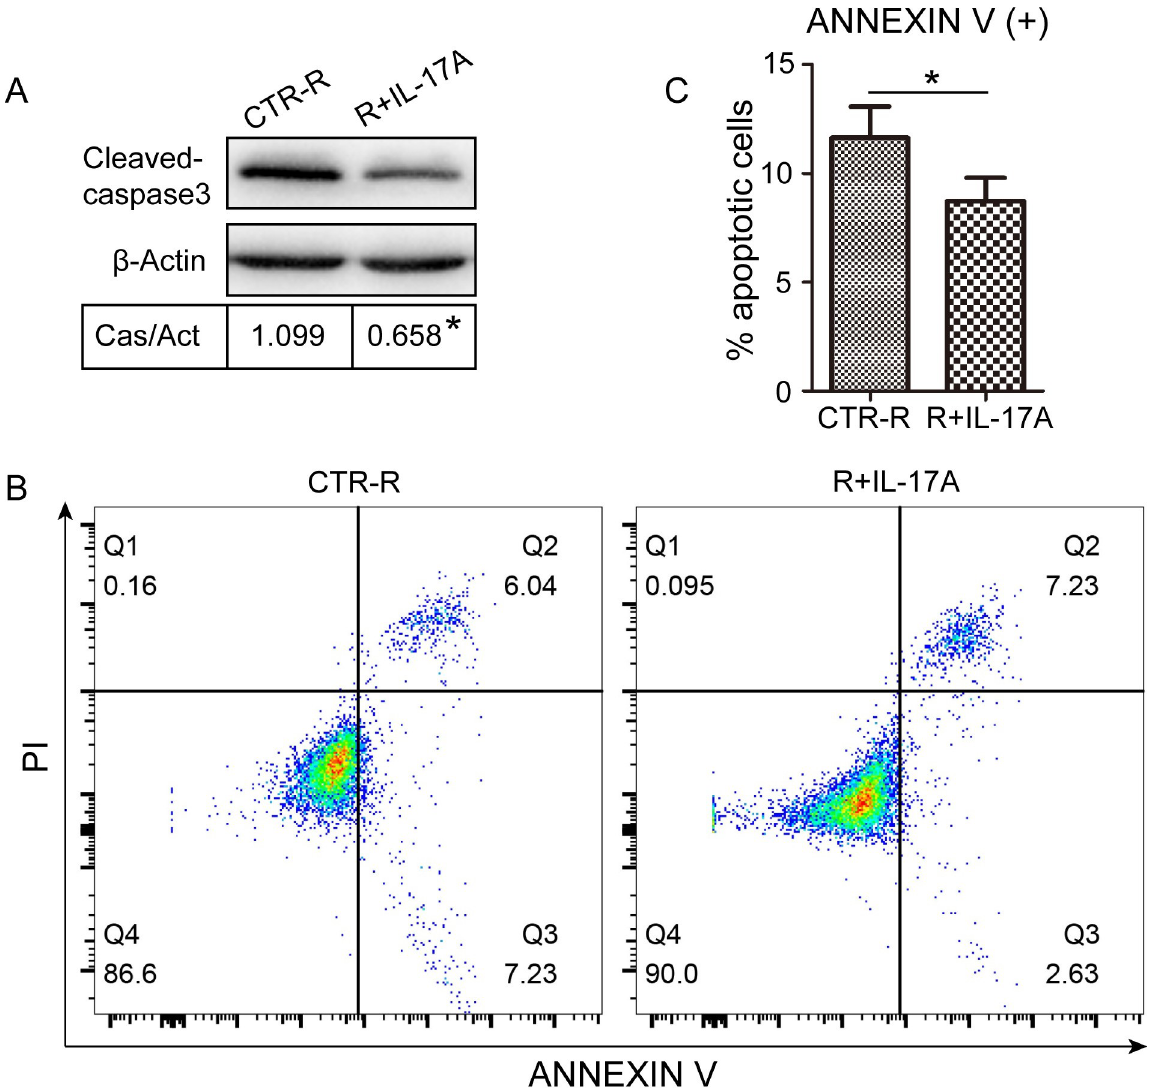
Fig 4. IL-17A inhibits apoptosis of OCPs. RAW264.7 cells were treated with or without IL-17A (1 ng/ml) in the presence of RANKL (50 ng/ ml) for 24 h, cleaved caspase-3 was detected by western blotting (A), and Annexin V-FITC/PI staining was performed to label apoptotic cells. The percentages of apoptotic cells (Annexin V+) were counted by flow cytometry (B), Q2 and Q3 quadrants indicated reduced apoptosis with IL-17A treatment (C). Protein expression was normalized against β -Actin. Cells not treated with IL-17A but exposed to RANKL (CTR-R) were used as control. Data are presented as the mean ± SD from three independent experiments. � p <